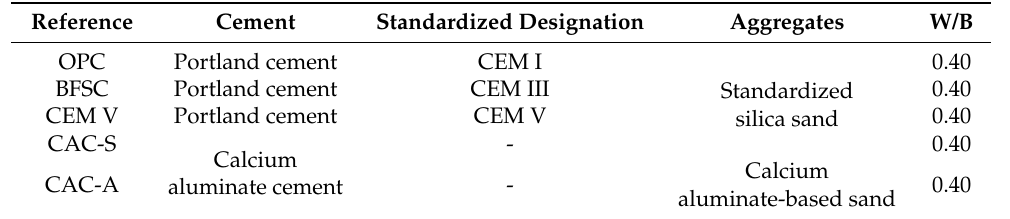
Table 2. Description of mortar